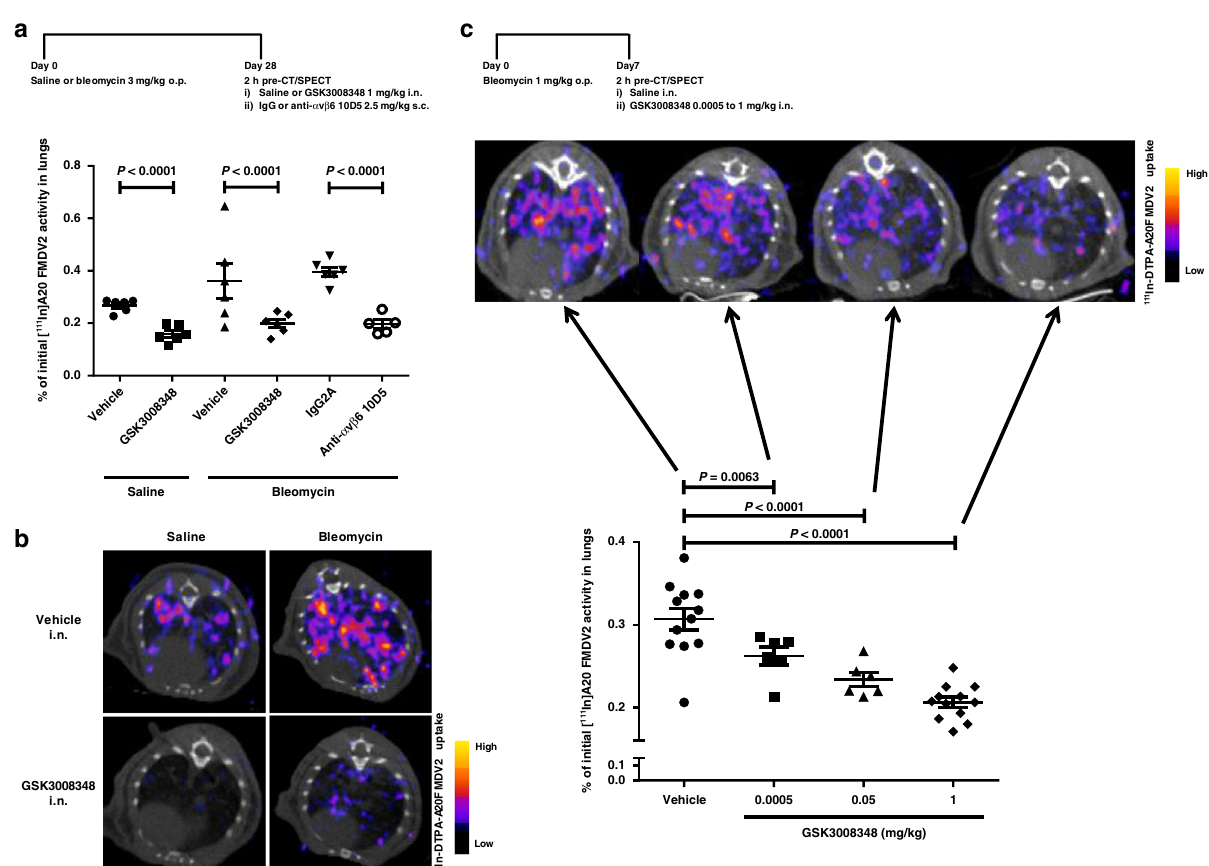
Fig. 4 In vivo engagement of α v β 6 via the inhaled route in a fi brotic lung. a Effect of GSK3008348 on the binding of the selective α v β 6 integrin nanoSPECT-CT ligand [ 111 In]A20FMDV2 in naive (saline treated) and bleomycin-treated mice following i.n. dosing (mean ± SEM; n = 5 – 6 animals per group; ANOVA with Fisher ’ s LSD post test comparisons versus corresponding vehicle or IgG2A control or between active groups). b Representative axial SPECT/CT scans of thorax detected binding of [ 111 In]A20FMDV2 in lungs of naive (saline treated) or bleomycin-treated mice receiving vehicle (i.n. saline) or GSK3008348 (1 mg/kg) from the study shown in panel a . c Dose-dependent effect of GSK3008348 on the binding of the selective α v β 6 integrin nanoSPECT-CT ligand [ 111 In]A20FMDV2 in bleomycin-treated mice following i.n. dosing (mean ± SEM; n = 6 – 12 animals per group; ANOVA with Fisher ’ s LSD post test comparisons versus vehicle i.n. control). Representative axial SPECT/CT scans of thorax detected binding of [ 111 In]A20FMDV2 also shown. Source data are provided as a Source Data fi